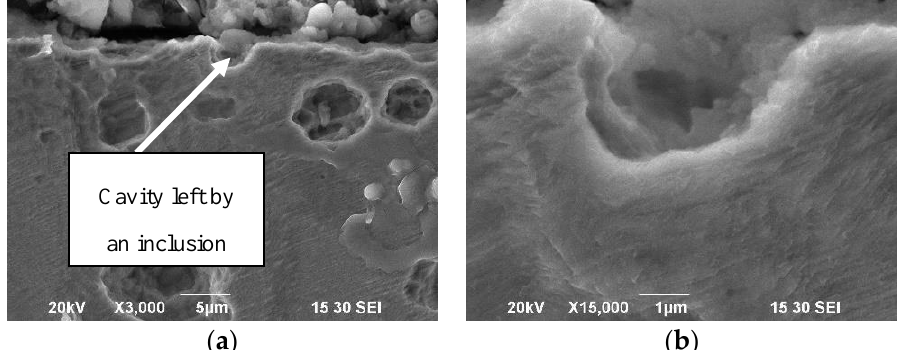
Figure 7. Wear surface in high manganese steel castings doped with ferrovanadium nitride: ( а ) general view; ( b ) cavity left by a carbide (nitride).